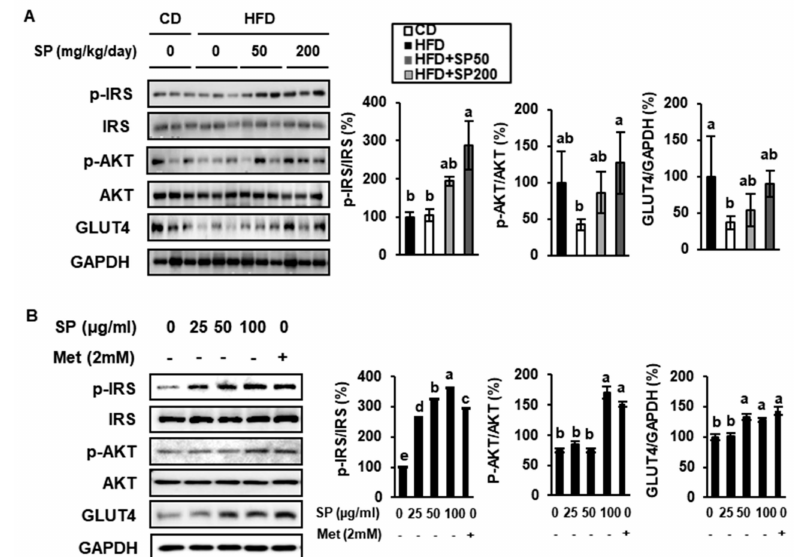
Figure 4. E ff ect of silk peptide on insulin resistance in visceral adipose tissue from high-Figure 3. T3- L1 cells. ( A ) Expression of proteins involved in glucose disposal (p-IRS, IRS, p-AKT, AKT, and GLUT4) in VAT, analyzed by western blotting. ( B ) Expression levels of proteins involved in insulin sensitivity in 3T3-L1s compared with cells treated with 2 mM metformin (Met). The data were analyzed using one-way ANOVA and Duncan’s test. Values with di ff erent letters are significantly di ff erent; p < 0.05 (a > b > c > d >